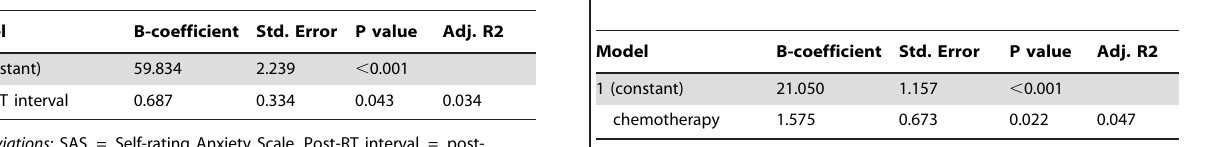
Table 5. Multiple linear regression analysis of age, gender, education, post-RT interval, and chemotherapy to